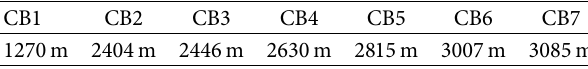
Table 3: Distance between possible connection point and DG site.